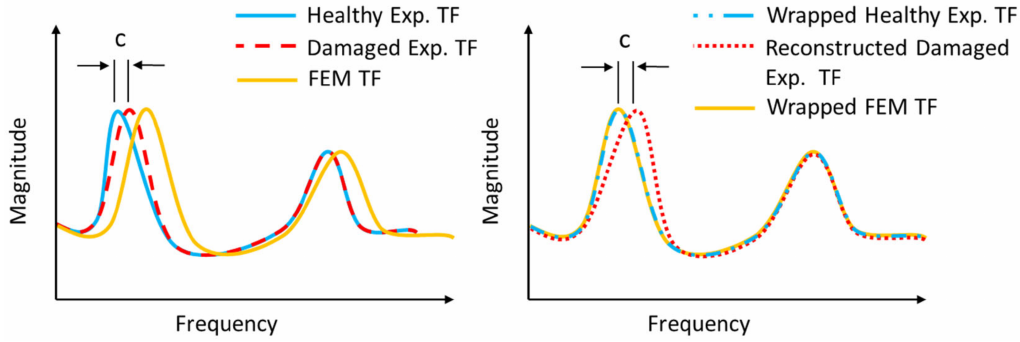
Figure 1. Pattern recreation using DTW wrapping